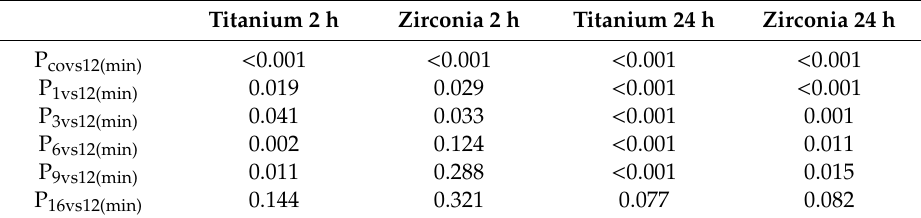
Table 2. Statistical results of one-way analysis of variance test in 12 min UV-light treated